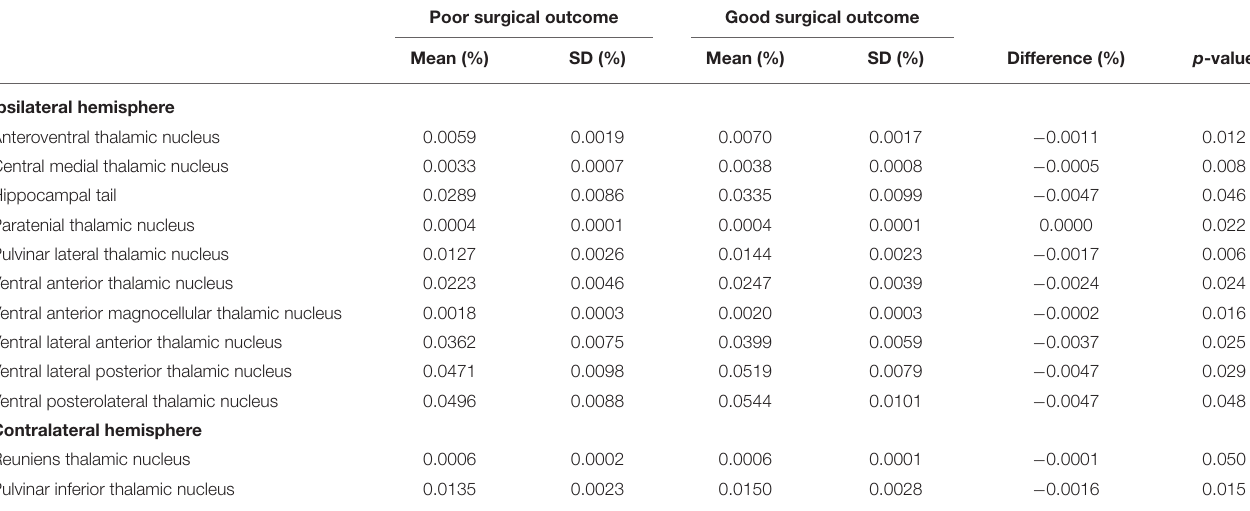
TABLE 2 | Volumes of the amygdala nuclei, hippocampal subfields, and thalamic nuclei in temporal lobe epilepsy patients with hippocampal sclerosis according to surgical outcome. Poor surgical